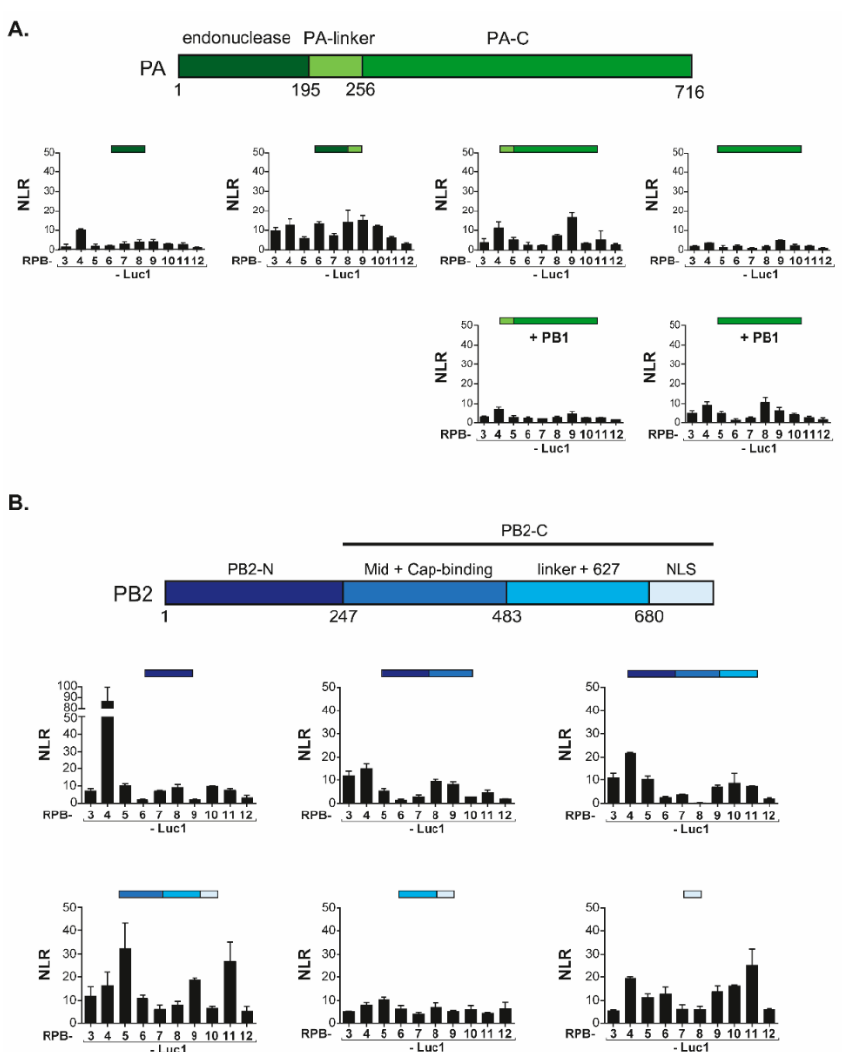
Figure 3. Split-luciferase assays between PA and PB2 domains of FluPol and Pol II subunits. ( A ) Luc1-PA domains and Luc2-subunits of Pol II were co-expressed into HEK293T cells along with PB1 or an empty plasmid. Twenty-four hours post-transfection, cells were lysed and luminescence was measured. NLR were determined as shown in Figure 1B. ( B ) Luc1-PB2 domains and Luc2-subunits of Pol II were co-expressed into HEK293T cells with NLR determined as shown in Figure 1B. Data are mean ± s.d. n = two technical